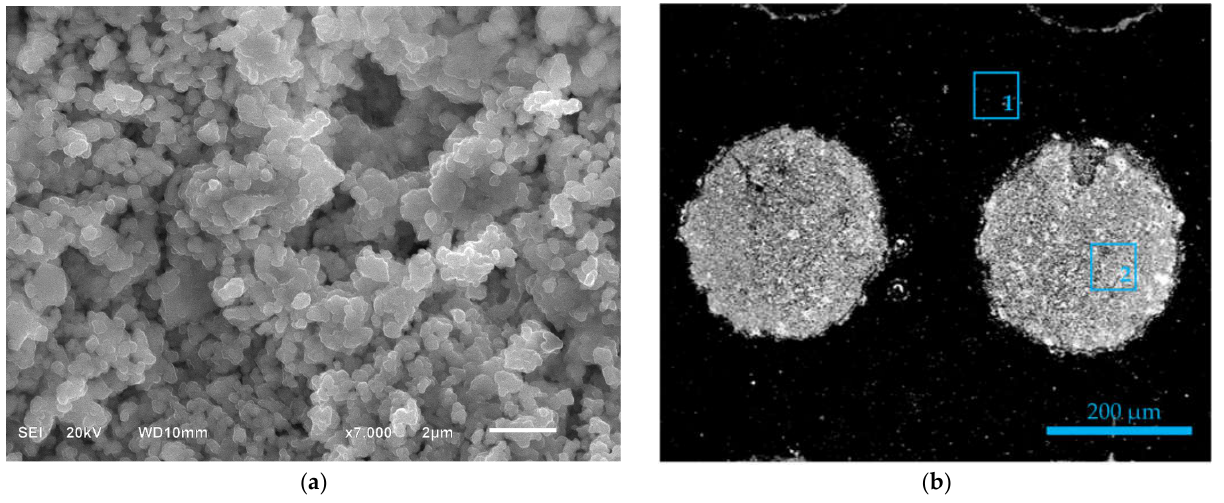
Figure 4. ( a ) High-resolution SEM image of the surface of BST/LMG composite. ( b ) SEM image of the hole filled by composite and areas of EDS analysis (spot 1–NiFe 2 O 4 matrix; spot 2–BST/LMG Table 1. EDS analysis data.